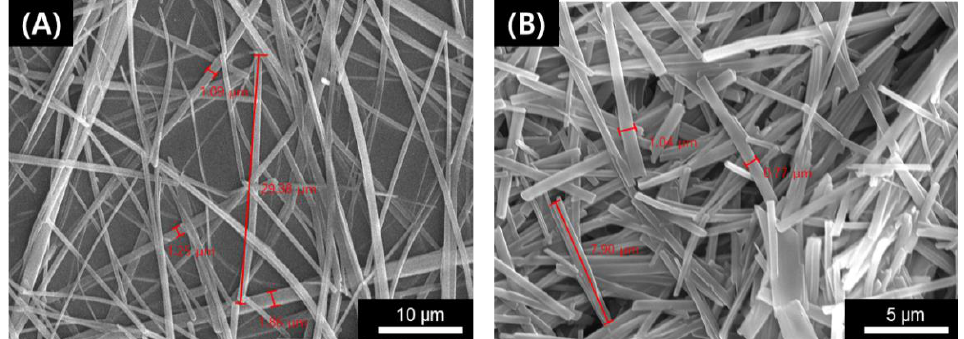
Figure 5. SEM images of xerogels of 1 ( A ) without and ( B ) with Zn 2+ in ACN.